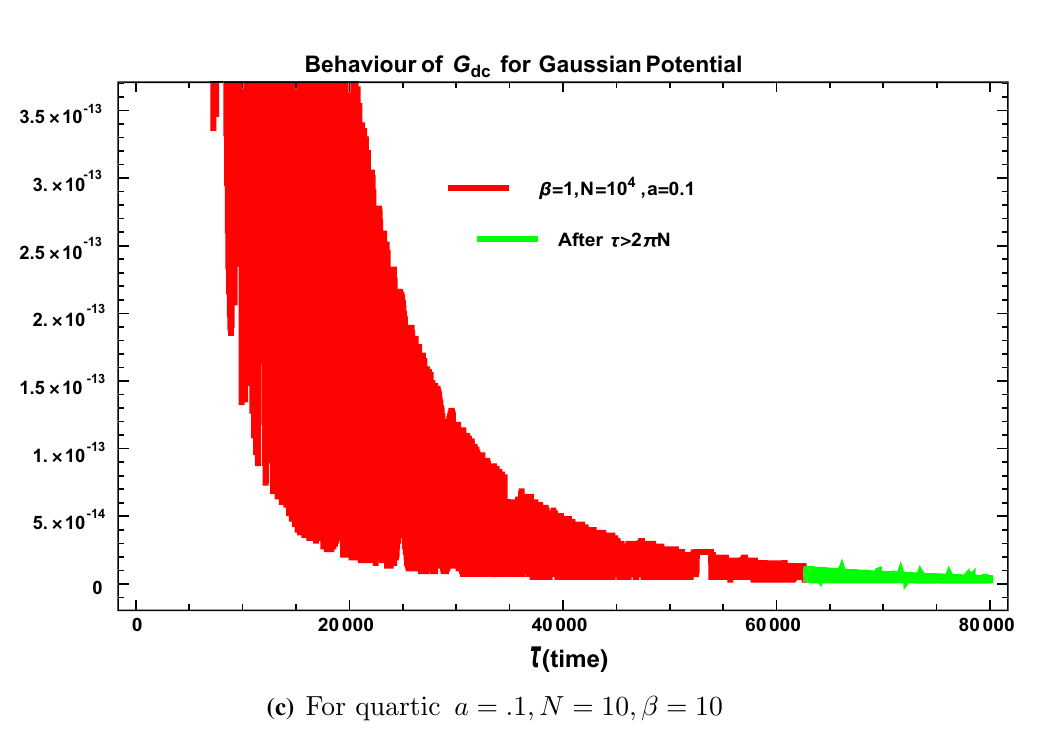
Fig. 34 G dc at different N and